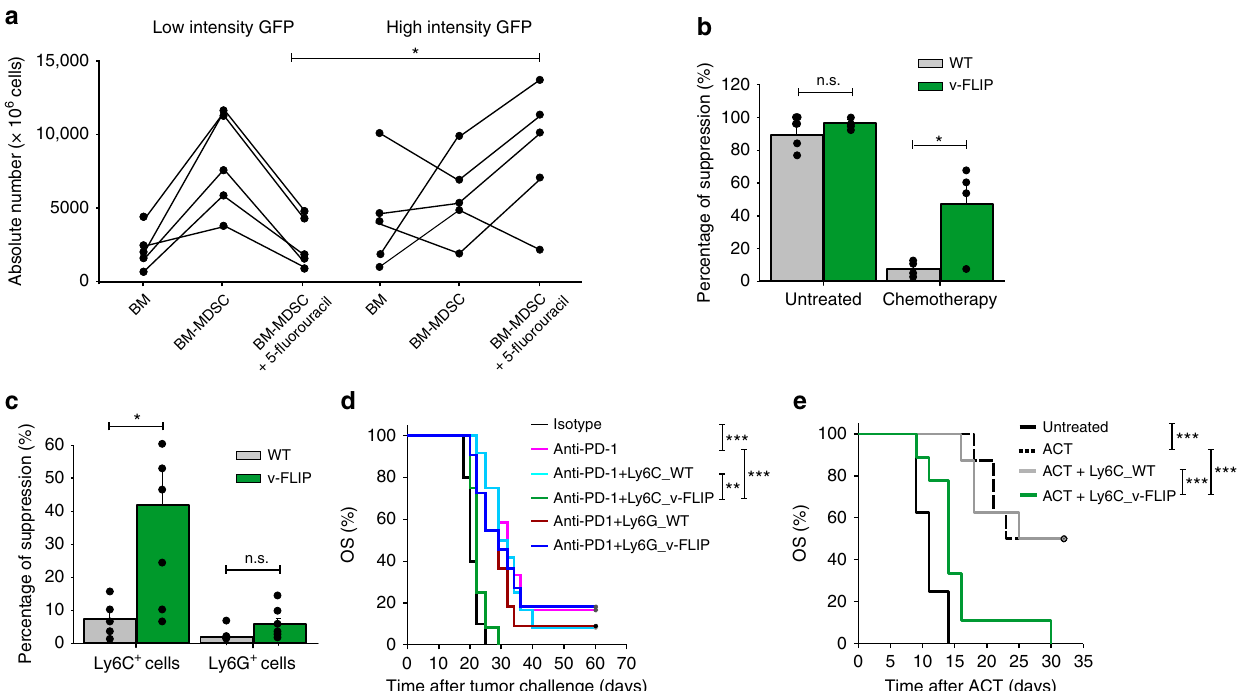
Fig. 2 v-FLIP + Ly6C + cells are chemotherapy-resistant and immunosuppressive. a Absolute numbers of CD11b + Ly6C + cells isolated from Tg mice in fresh BM, in vitro differentiated BM-MDSCs and in vitro differentiated, 5- fl uorouracil-treated BM-MDSCs. b Suppressive activity of BM-MDSCs derived from 5- fl uorouracil-treated BM of Tg mice was measured using peptide-activated CD8 + T cells by fl ow cytometry. c Suppressive activity of monocytic (CD11b + Ly6G - Ly6C high cells) and PMN (CD11b + Ly6G + Ly6C low cells) myeloid subsets freshly isolated from the BM of WT and Tg mice were measured using CellTrace-labeled OT-I cells. d Kaplan – Meier survival analysis of MCA205 tumor-bearing mice ( n = 12 mice/group) treated with anti-PD-1 mAb (pink line) or isotype Ab (black line) using 4 intraperitoneal administrations every 2 days. Three days from the last treatment, some mice received the adoptive transfer of myeloid cells freshly isolated from the BM of either Tg or WT mice: v-FLIP-expressing Ly6C + (green line), v-FLIP-expressing Ly6G + cells (dark blue line), Ly6C + cells (light blue line) or Ly6G + cells (dark red line). e Kaplan – Meier survival analysis of EG7 tumor-bearing mice ( n = 5 mice/group) were injected intravenously (i.v.) with 10 6 OVA-speci fi c OT-I T lymphocytes (ACT) and, after 2 h, mice were infused i.v. with 0.5 × 10 6 CD11b + Ly6C + fresh monocytes isolated from either WT or Tg mice. Data are presented either as mean ± s.e.m. of three independent experiments ( b , c ) or as two